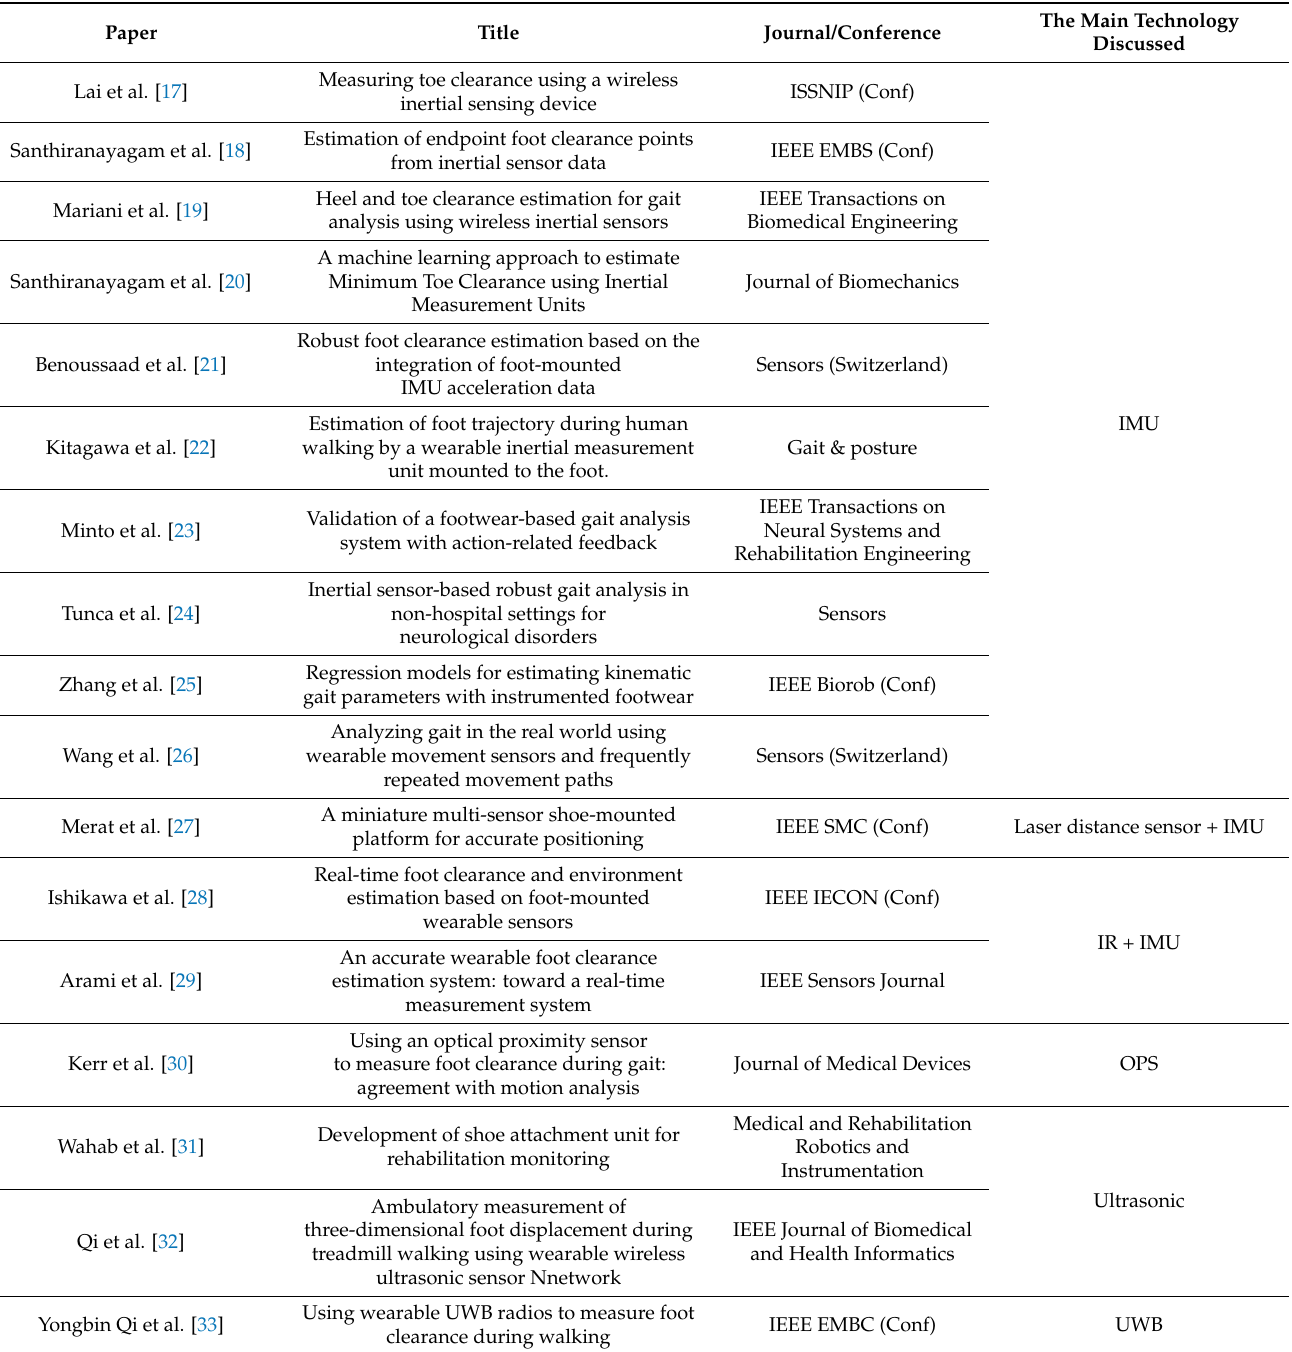
Table 1. General characteristics of the included papers (Conf, conference proceeding; IMU, inertial measurement unit; IR, infrared sensor; OPS, optical proximity sensors; UWB, ultra-wideband